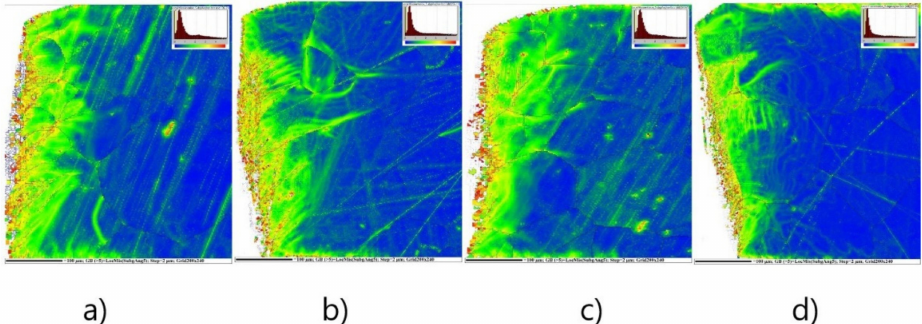
Figure 5. Local misorientation map of cutting surface cross-section of rings with cutting clearances corresponding to 1% ( a ), 3% ( b ), 5% ( c ), 7% ( d ) of the sheet thickness before annealing. The legend (the upper right corner) for angles ranging from 0–5 ◦ which are marked by rainbow colour and showing the higher deformation region.